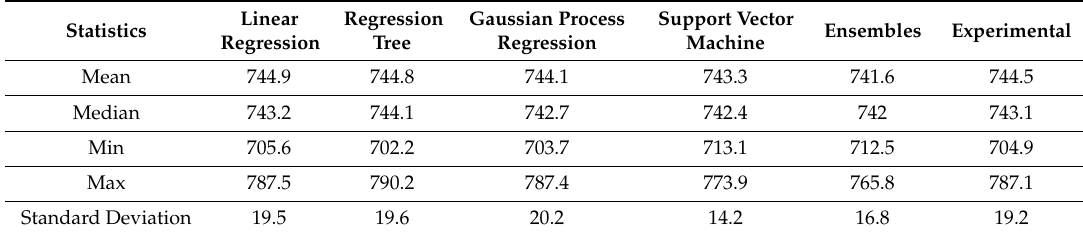
Table 4. Comparison between the statistics of the predicted values using di ff erent machine learning models with that of the experimental data of the temperature of the liquid aluminum.